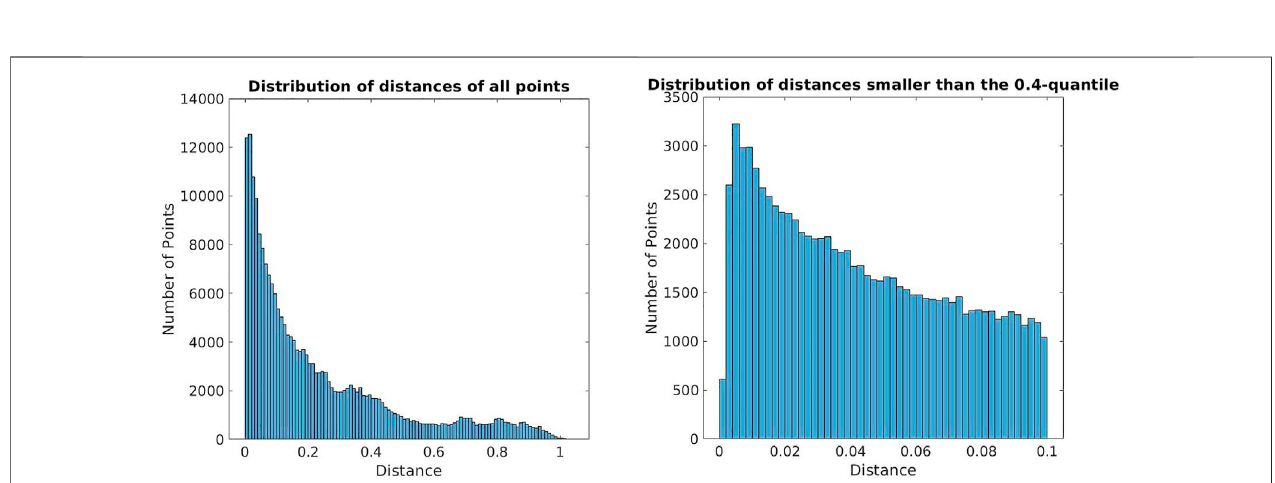
FIGURE 8 | Distribution of distances between the reconstructed points and the ground truth. On the left all reconstructed points are considered while the right graph takes only the points below the 0.4-quantile into account.